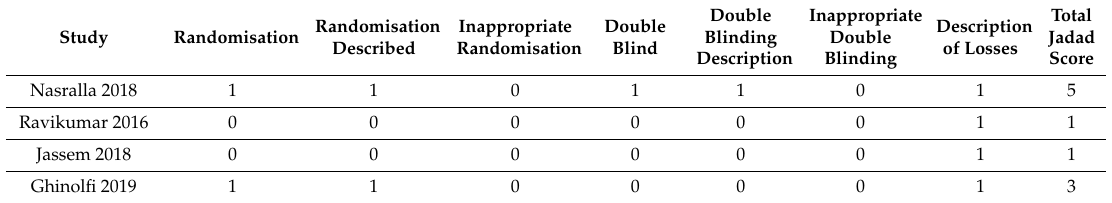
Table 7. Risk of bias assessment of studies comparing NMP and SCS in